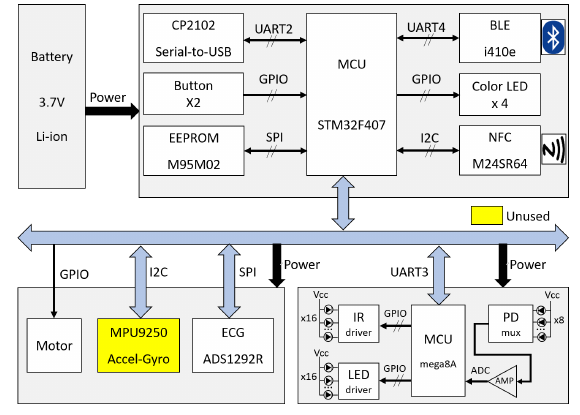
Figure 3. A block diagram of our in-house wearable security band